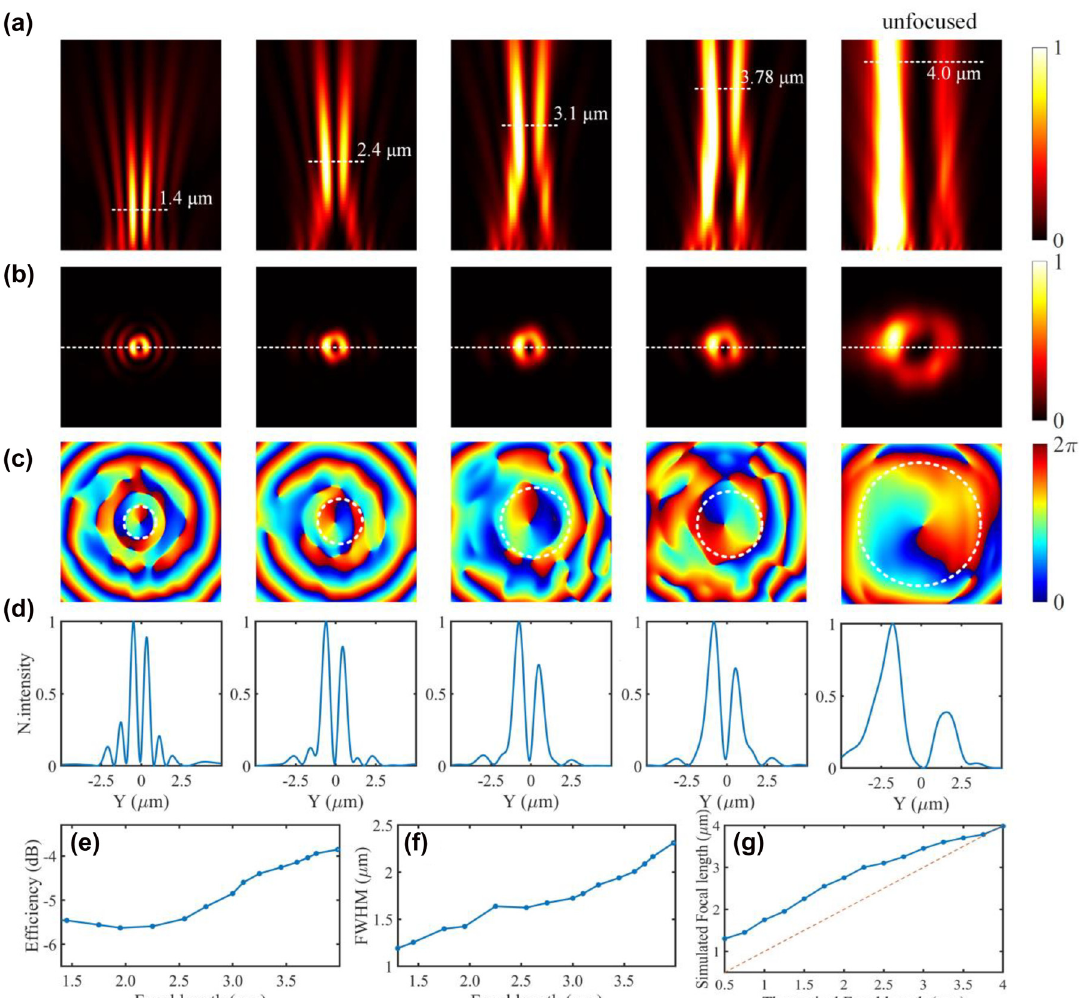
Figure 8: Simulated results for focused vortex beam generation. (a) The simulated intensity profiles along the x -axial plane. (b–d) The intensity, phase, and normalized longitudinal electrical field profiles of the OAM beam on the focal planes. (e–f) The scattering efficiency and the full width at half maximums (FWHWs) versus the focal length. (g) The theoretically designed focal length and the simulated focal